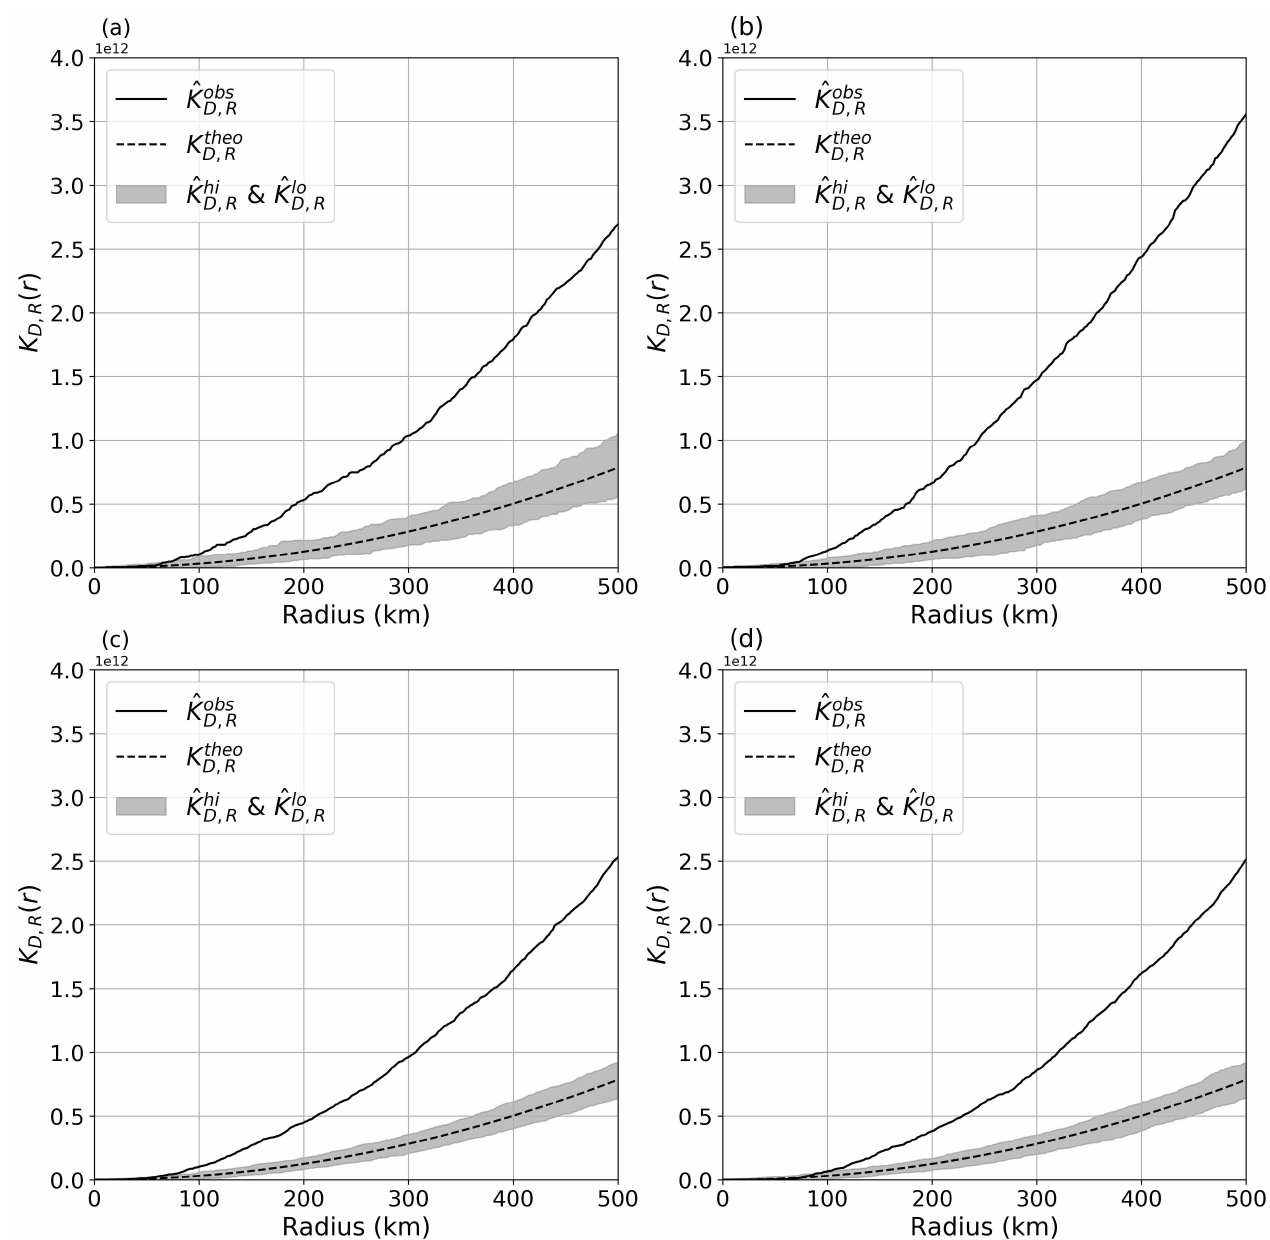
Figure 4. The results of the bivariate k function representing a significant spatial clustering tendency of cities with declining railway network properties around cities with rising properties. The network properties include the potential for transfer activity (PTA) for ( a ) D-series high-speed trains and ( b ) G-series high-speed trains and destination arrival probability (DAP) for ( c ) D-series high-speed trains and ( d ) G-series high-speed